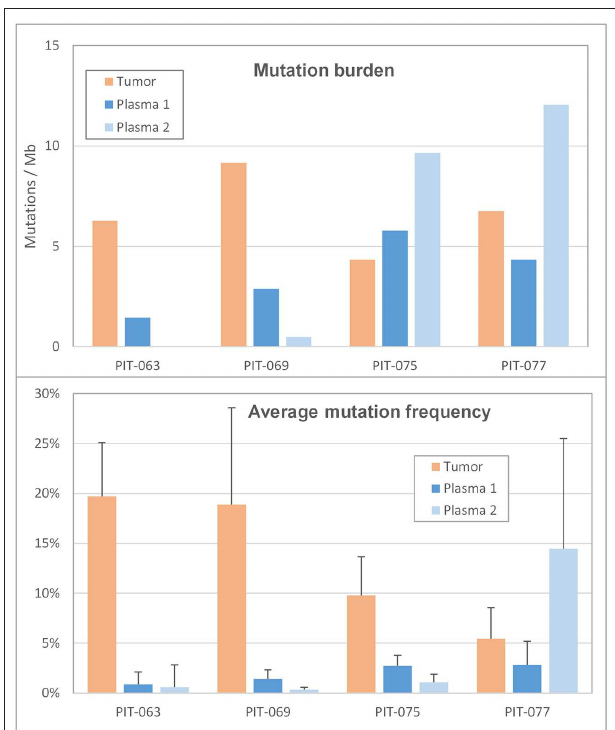
FIGURE 3 | Mutation profile ( Top ) mutation burden in the tumor and in the two plasma samples, expressed as the number of miscoding mutations per megabase. ( Bottom ) Average frequency of the alternate allele in the tumor and in the two plasma samples. Error bars are the standard